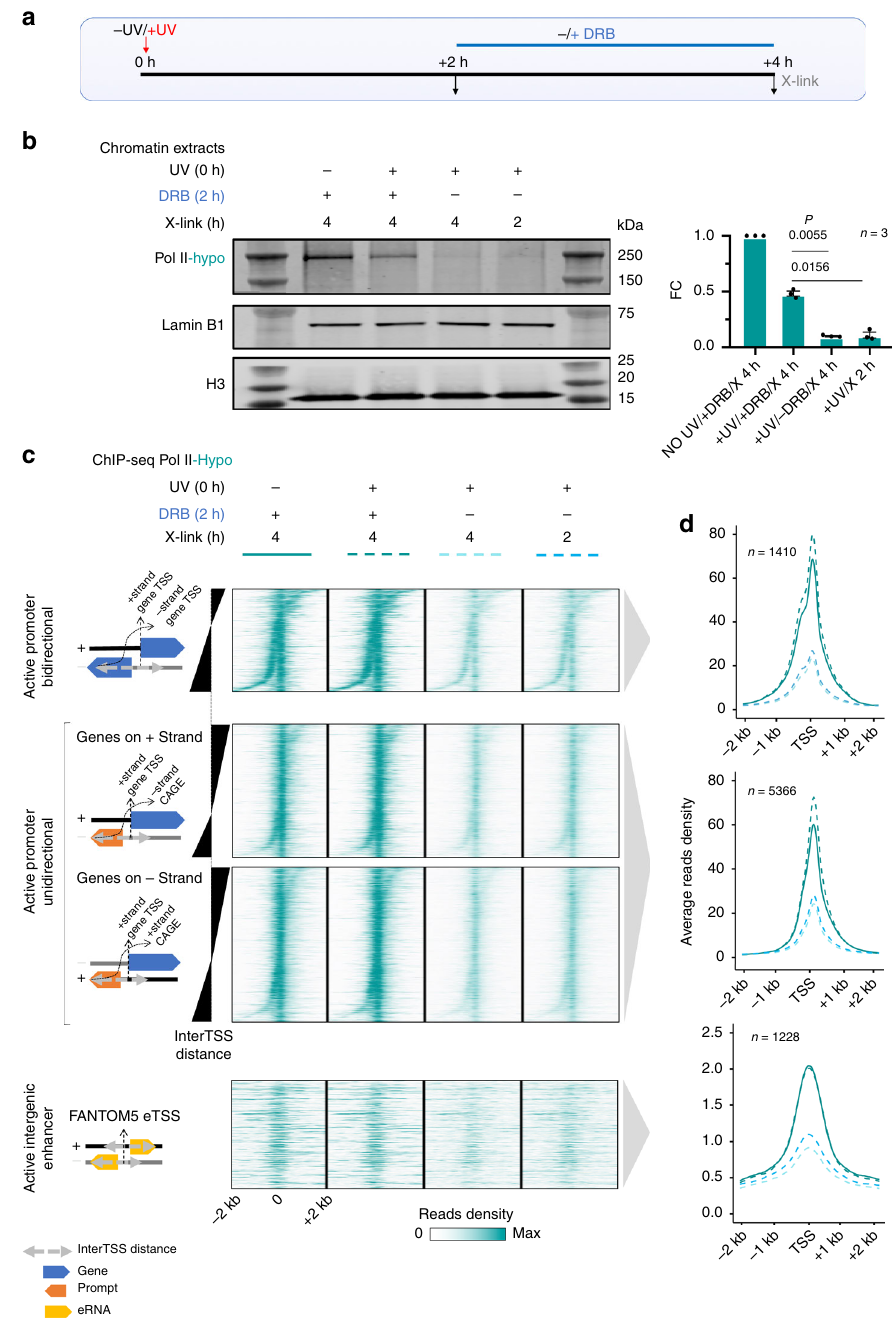
Fig. 4 DRB rescues pre-initiating Pol II levels following DNA damage. a Experimental timeline showing times of UV irradiation (15 J/m 2 ) and DRB treatment (see “ Methods ” ). b Western blot analysis of chromatin extracts for Pol II-hypo levels as examined after employing the experimental strategy described in a . Lamin B1 and histone H3 were used as loading controls. Bar graph represents quanti fi cation of Pol II-hypo levels as compared with the NO UV/ + DRB condition. Data shown re fl ect three independent experiments. Error bars represent S.E.M., and P values are calculated using two-sided Student ’ s t test. c Heatmap of Pol II-hypo ChIP-seq read densities in genomic regions 2 kb around TSS for categories de fi ned in Fig. 3 a – c after performing the combination of UV/DRB treatments described in a . d Average pro fi le plots of read densities analyzed in c